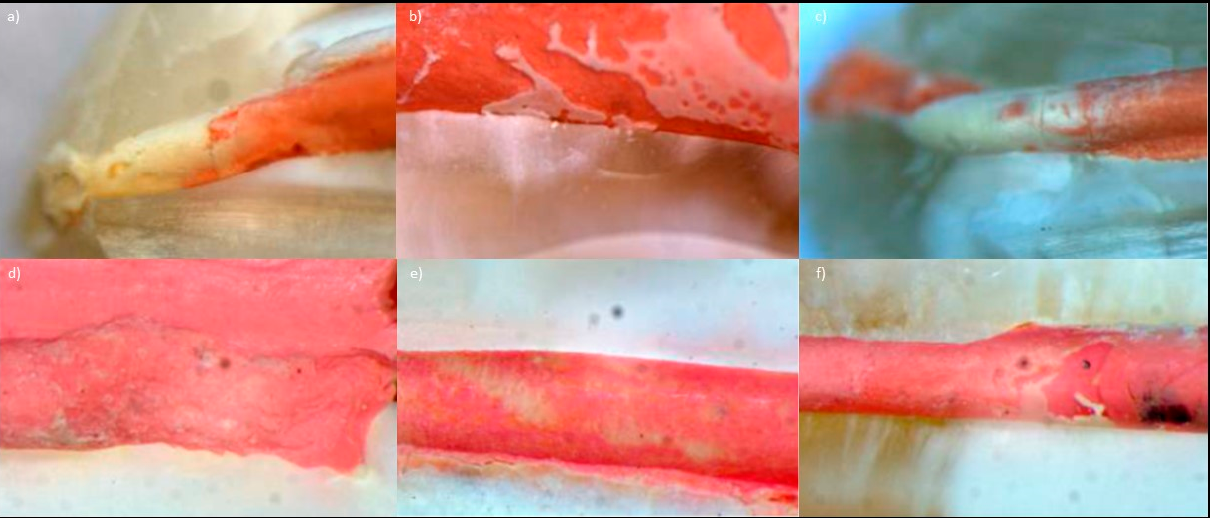
Figure 15. Longitudinal breakthroughs of teeth filled with material based on gutta-percha. ( a – c ) Thermoplastic obturation method: ( a ) accumulation of a thick intermediate layer of sealant in the apical area of the root canal; ( b ) uneven coverage of the material based on gutta-percha with a thin intermediate layer of sealant in the middle of the root canal; ( c ) accumulation of a larger intermediate layer of sealant in the apical region of the root canal. ( d – f ) THC thermoplastic obturation method: ( d ) a thin intermediate layer of sealant covering the material based on gutta-percha and bordering the root canal wall in the near-crown segment; ( e ) a thin interlayer of sealant completely covering the material based on gutta-percha in the apical region; ( f ) a thin intermediate layer of sealant covering the material based on gutta-percha and its greater accumulation in the centre of the root canal, viewed with LSM.